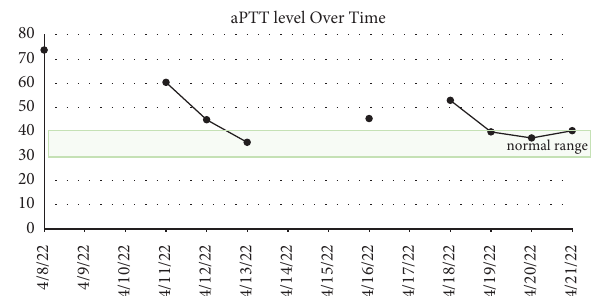
Figure 3: Activated partial thromboplastin time (aPTT) over time. Transfusions 1 and 2 with corresponding allergic reactions took place on 4/8/22. Transfusion 3 with pretransfusion medication to limit allergic reaction symptoms, a total of 2 units, took place on 4/ 11/22. Transfusion 4, similar to transfusion 3, but with 3 units in total took place on 4/12/22. Te CABG took place on